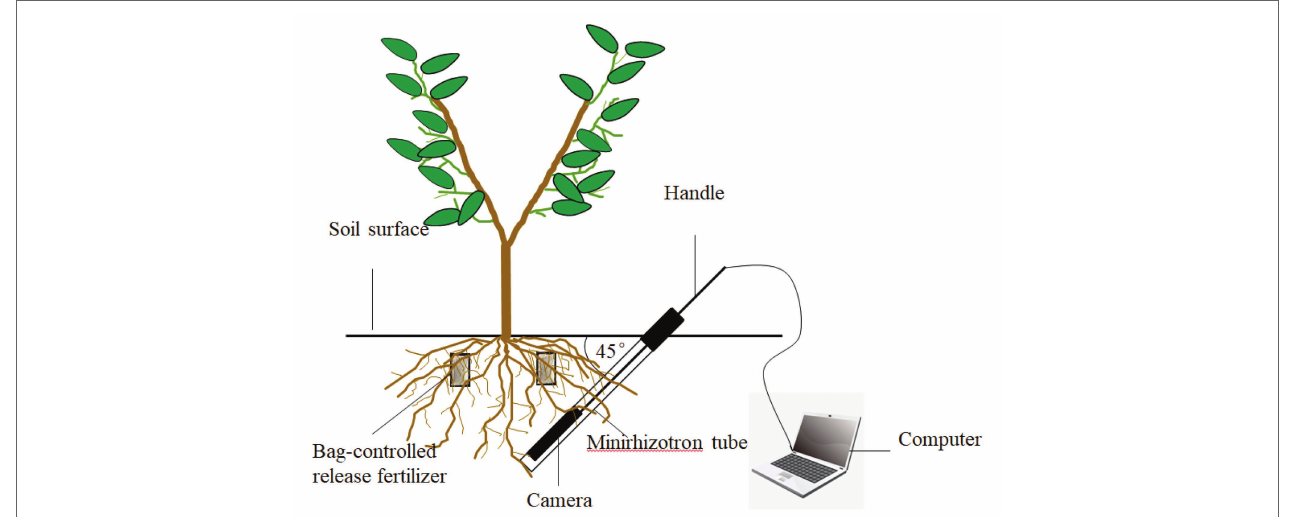
FIGURE 2 | Installation of minirhizotron